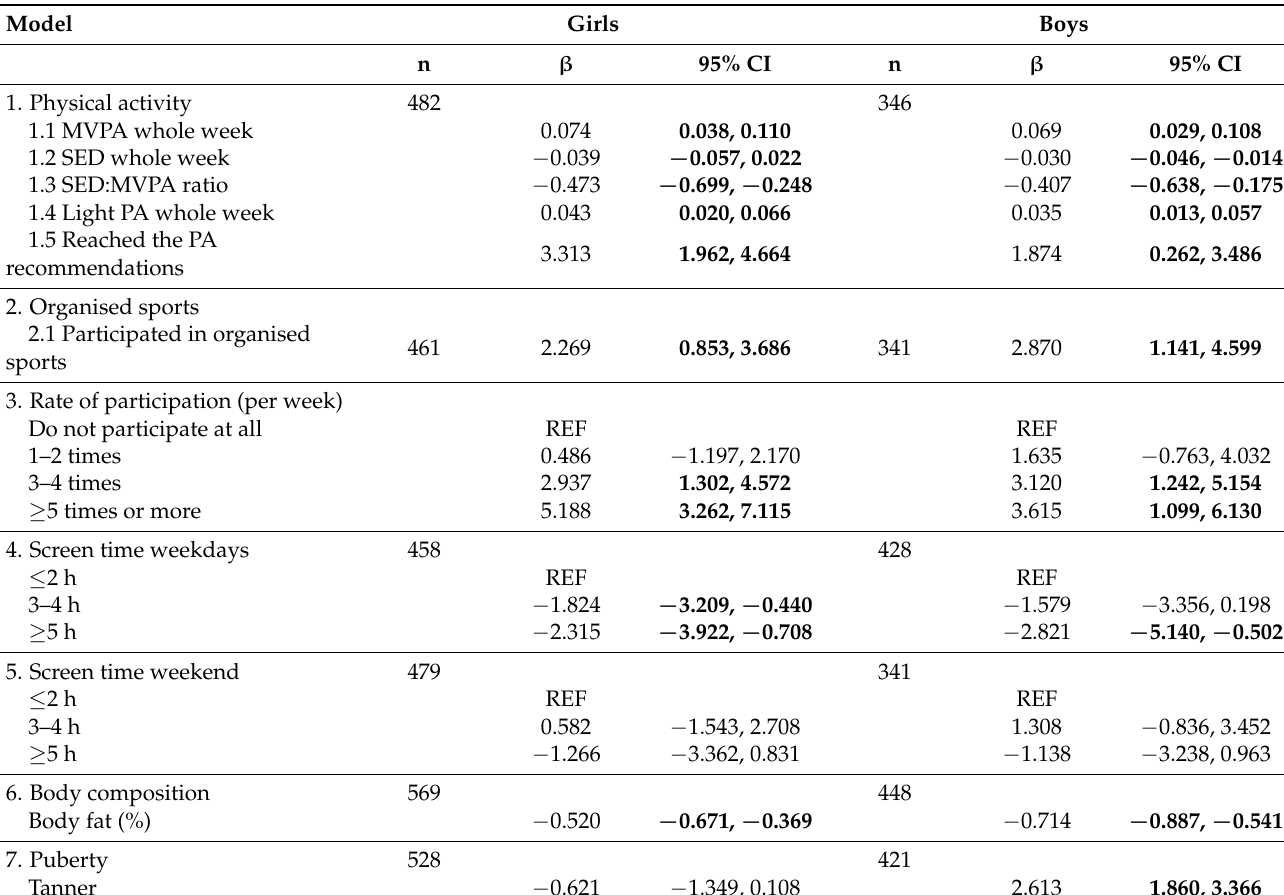
Table 3. Associations between predictors and fitness analysed with linear regression models controlled for BMI, and wear time, stratified by